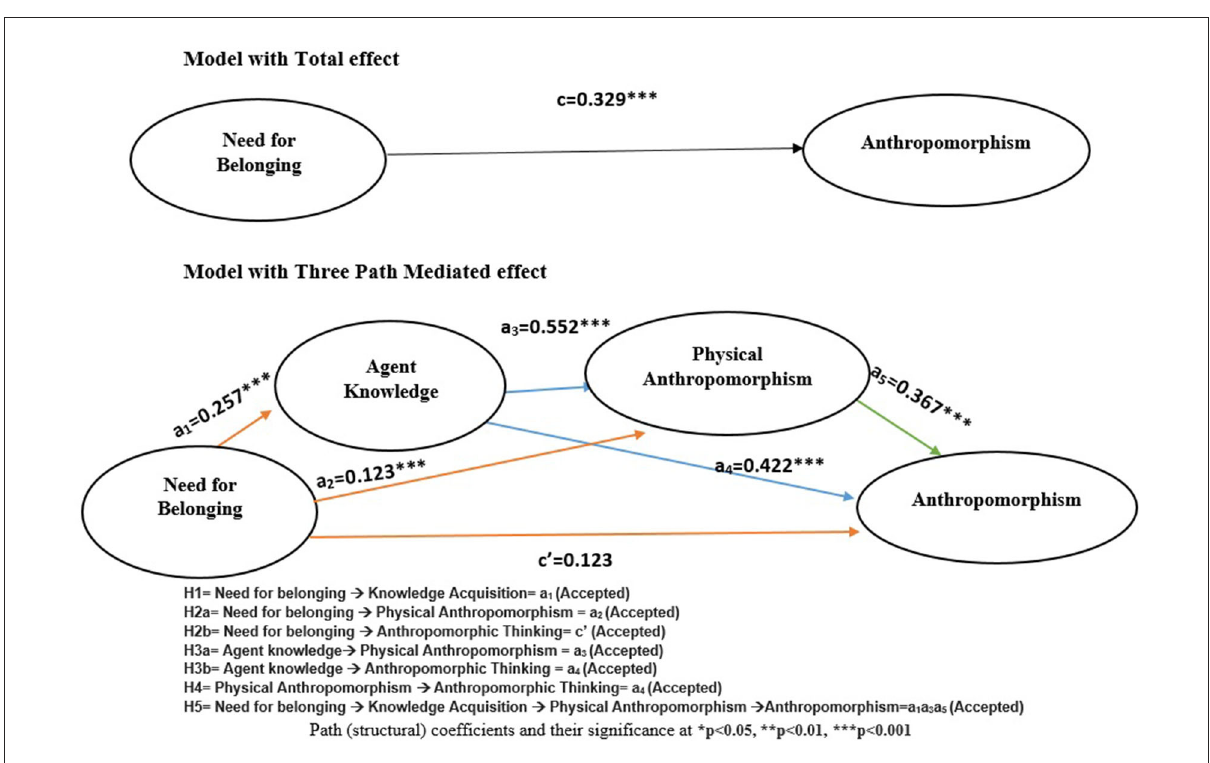
FIGURE4 Direct, indirect, and total effects of need for belonging on anthropomorphic